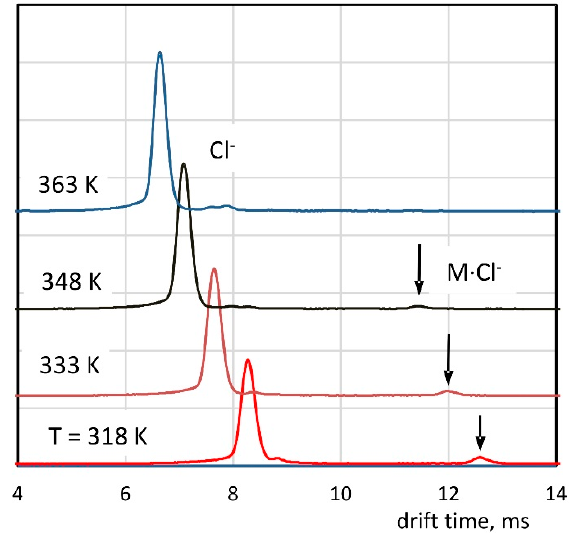
Figure 4. Drift time spectra with the introduction of the sample with the carrier gas.